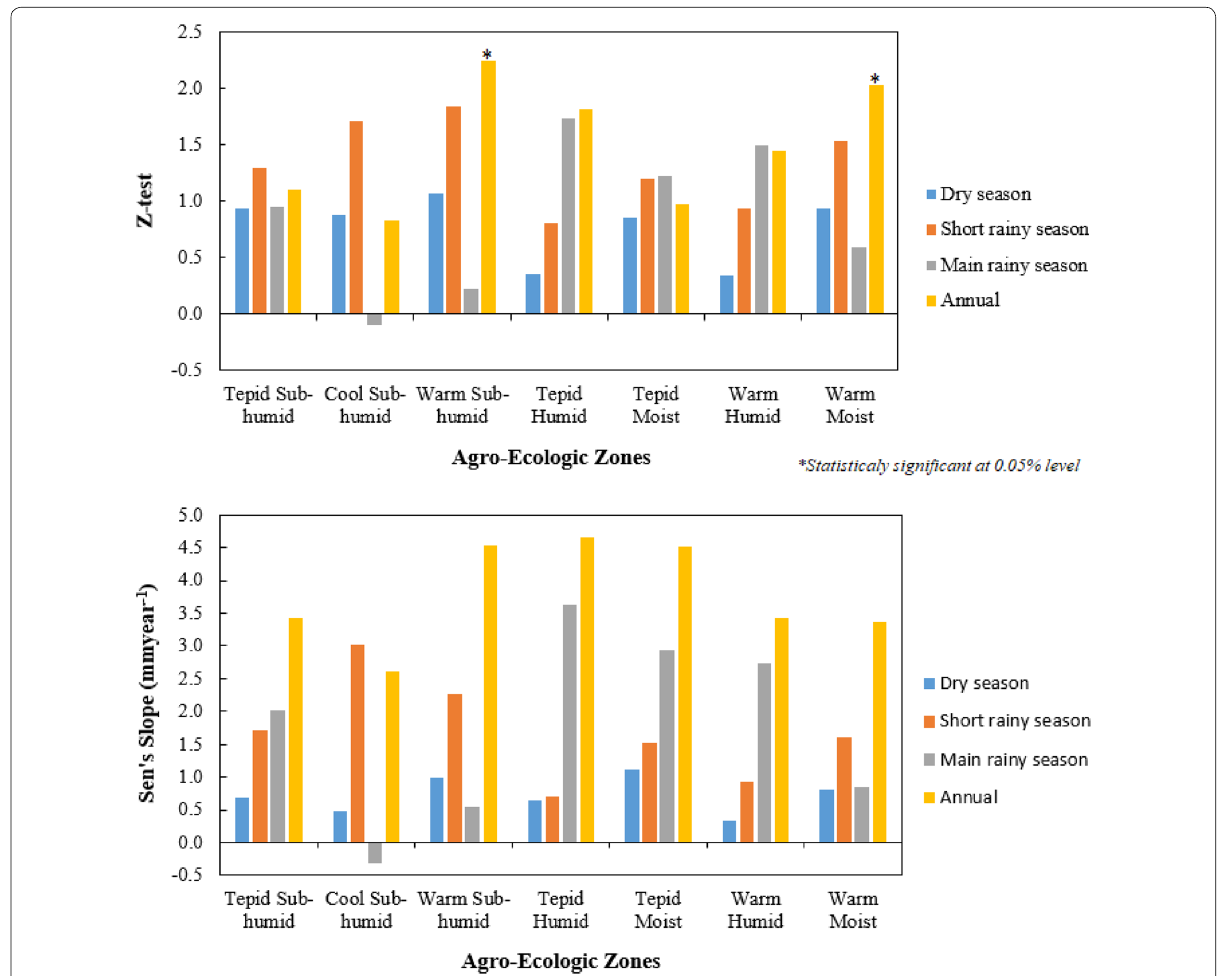
Fig. 2 Z-test (top) and Sen’s slope (bottom) of rainfall trend